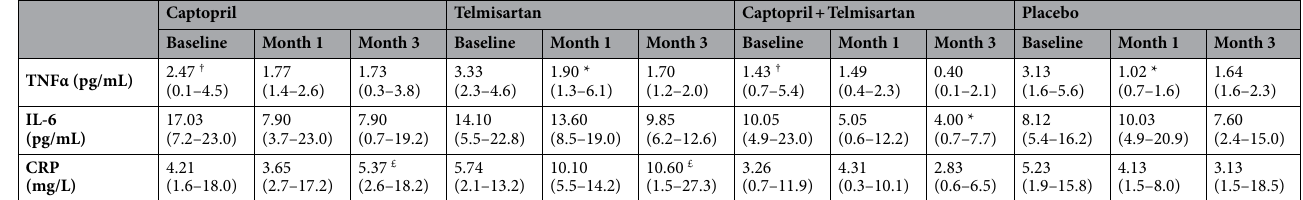
Table 3. Comparison of biochemical variables between groups at the beginning and the end of the study.